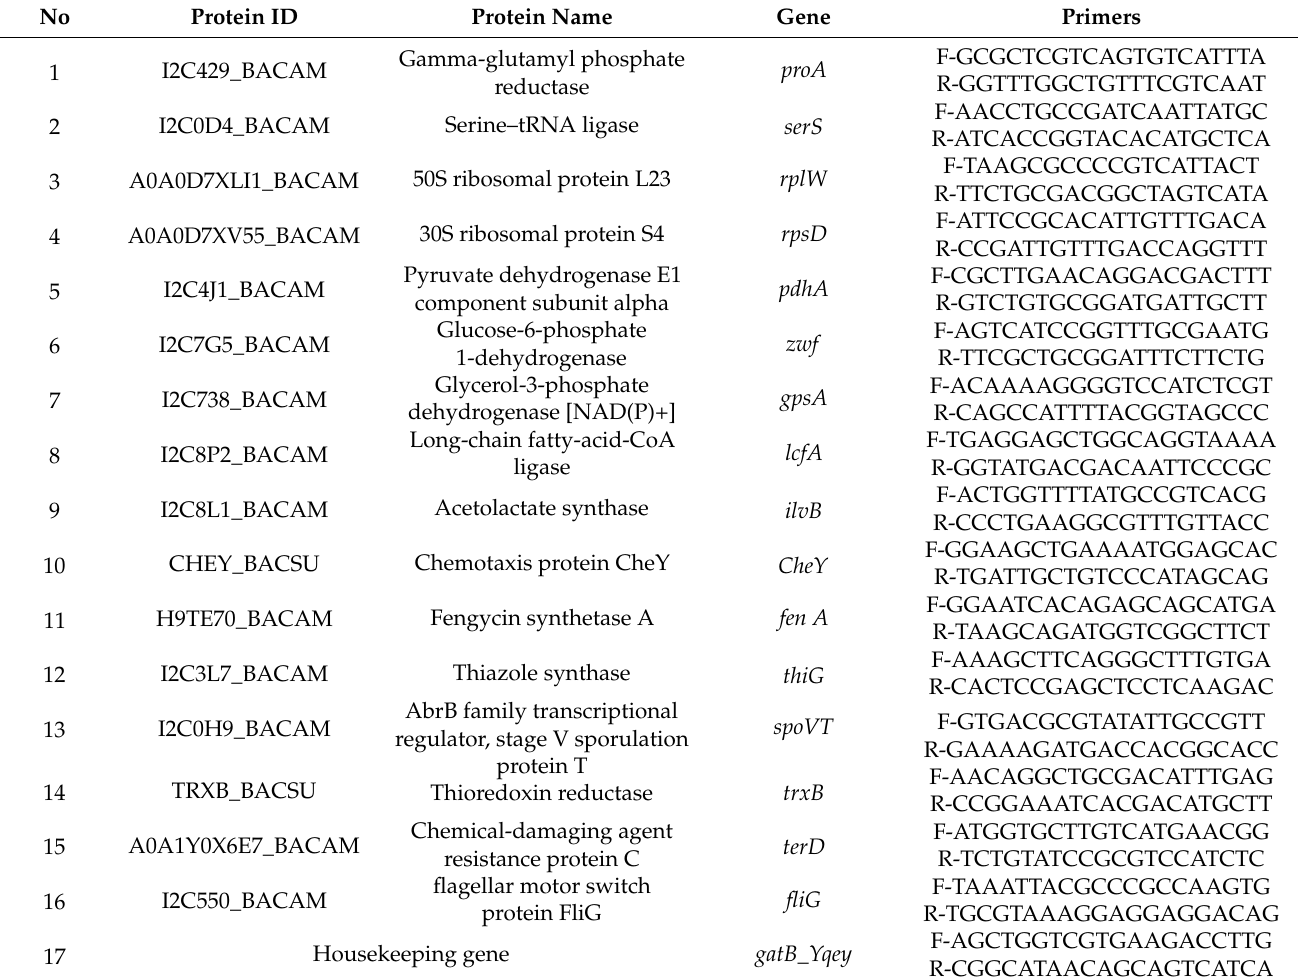
Table 1. Primers used for quantitative RT-PCR Analysis for selected